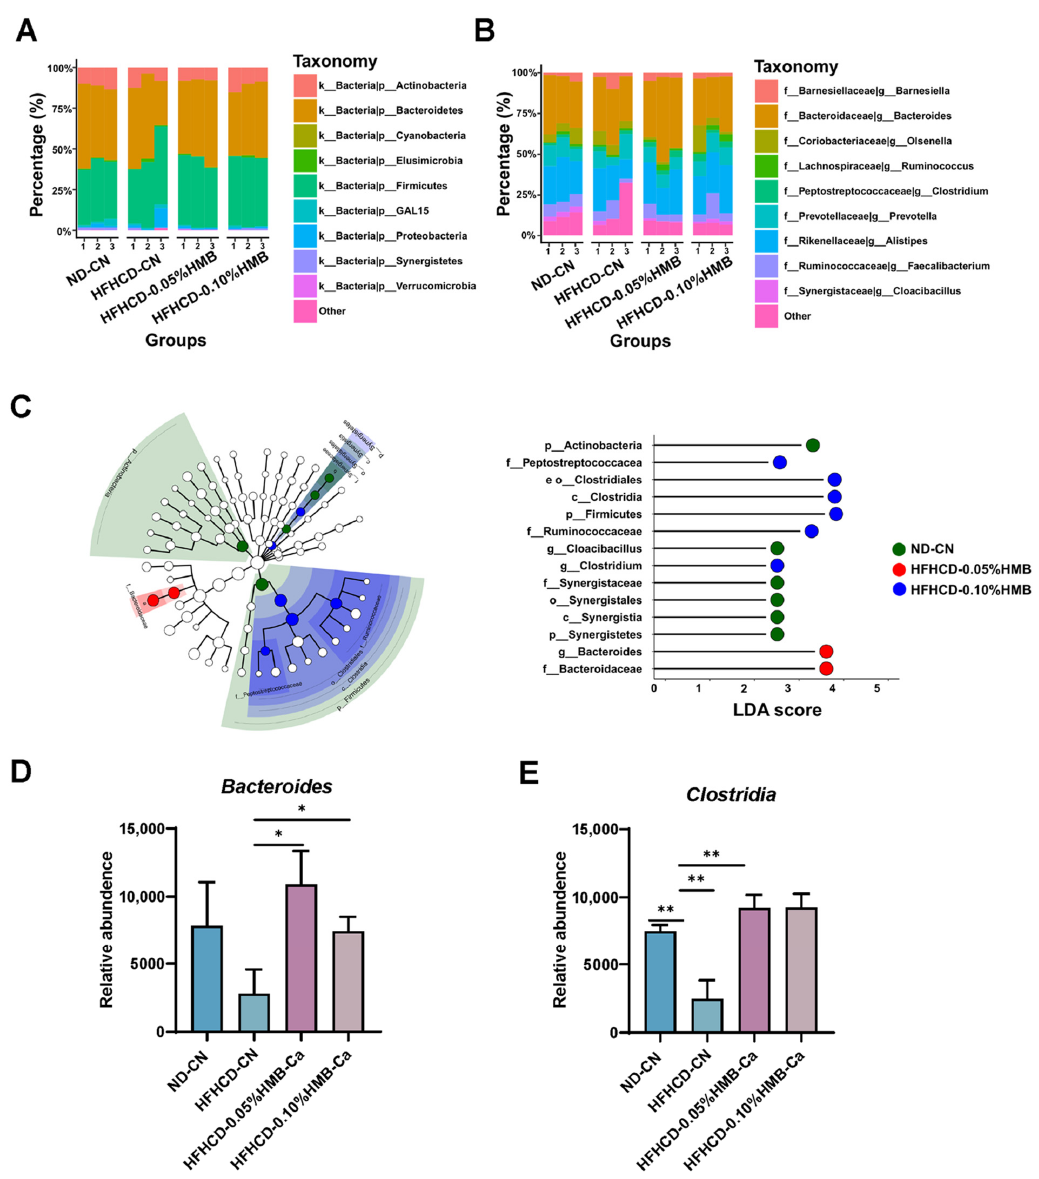
Figure 6. Effects of HMB on the composition of gut microbiota in HFHCD–challenged layers. ( A ) Microbiota composition at the phylum level. ( B ) Microbiota composition at the genus level. ( C ) The analysis of the non-parametric factors Kruskal–Wallis rank-sum test and LDA discrimination. ( D ) The abundance of Bacteroidetes in gut microbiota ( n = 3). ( E ) The abundance of Clostridia in gut microbiota ( n = 3). The results are shown as the means ± SDs; * p < 0.05, ** p <